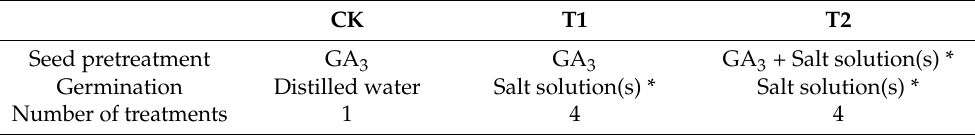
Table 1. Treatments for seed soaking, stratification, and germination under salt stress. CK T1 T2 Seed pretreatment GA 3 GA 3 GA 3 + Salt solution(s) * Germination Distilled water Salt solution(s) * Salt solution(s) * Number of treatments 1 4